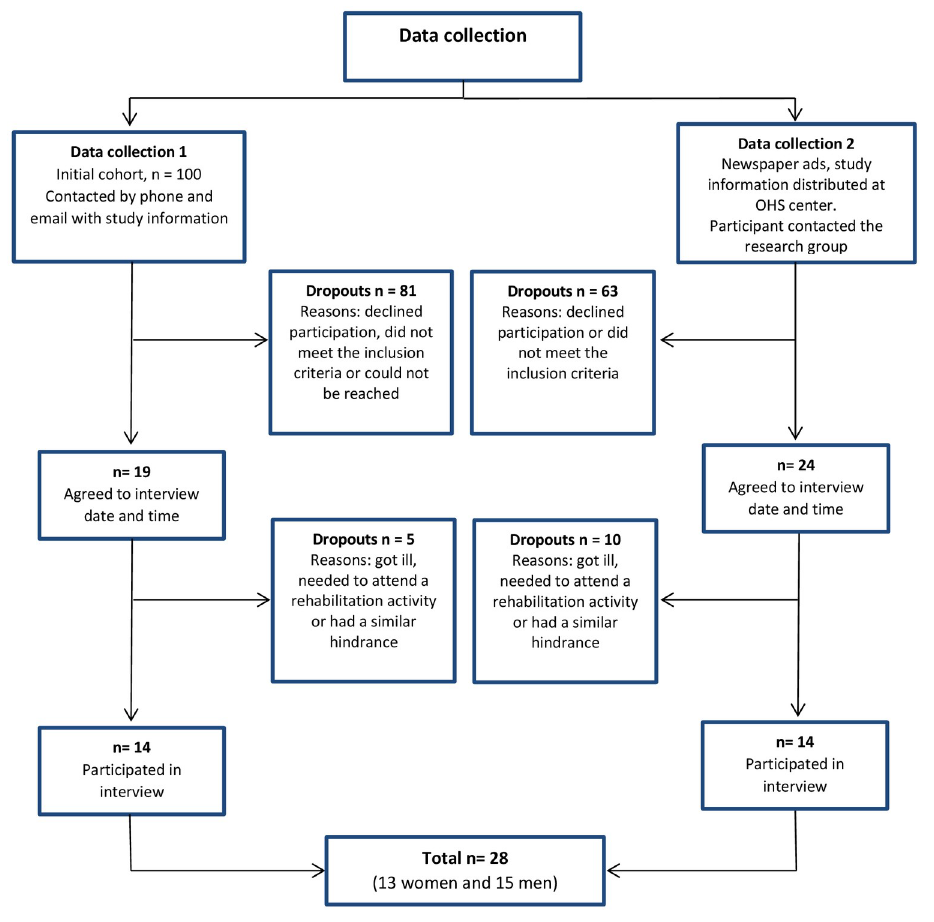
Fig 1. Flow chart of the data